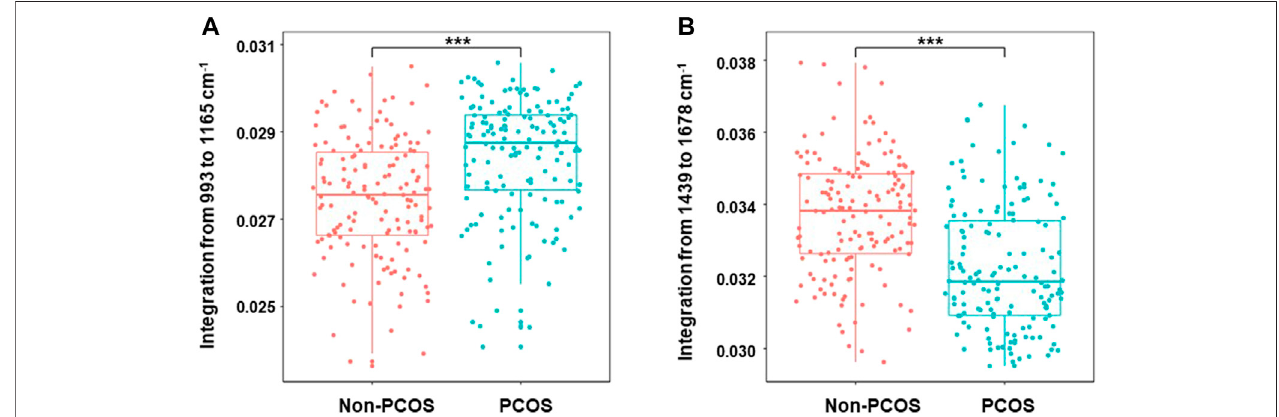
FIGURE3| BoxplotsofRamanbandintegrationofPCOSandnon-PCOSsamples.Thesigni fi cantdifferencesat993 – 1,165 cm − 1 (A) and1,439 – 1,678 cm − 1 (B) were shownbetweenPCOSandnon-PCOSgroups.Therectangleintheboxplotsrepresentsthesecondandthethirdquartiles,withthelineinsiderepresentingthemedian.The lower and upper quartiles are drawn as lines outside the box. Sample means were compared by Welch 2-sample t test for unequal variances. *** indicates p < 0.001.